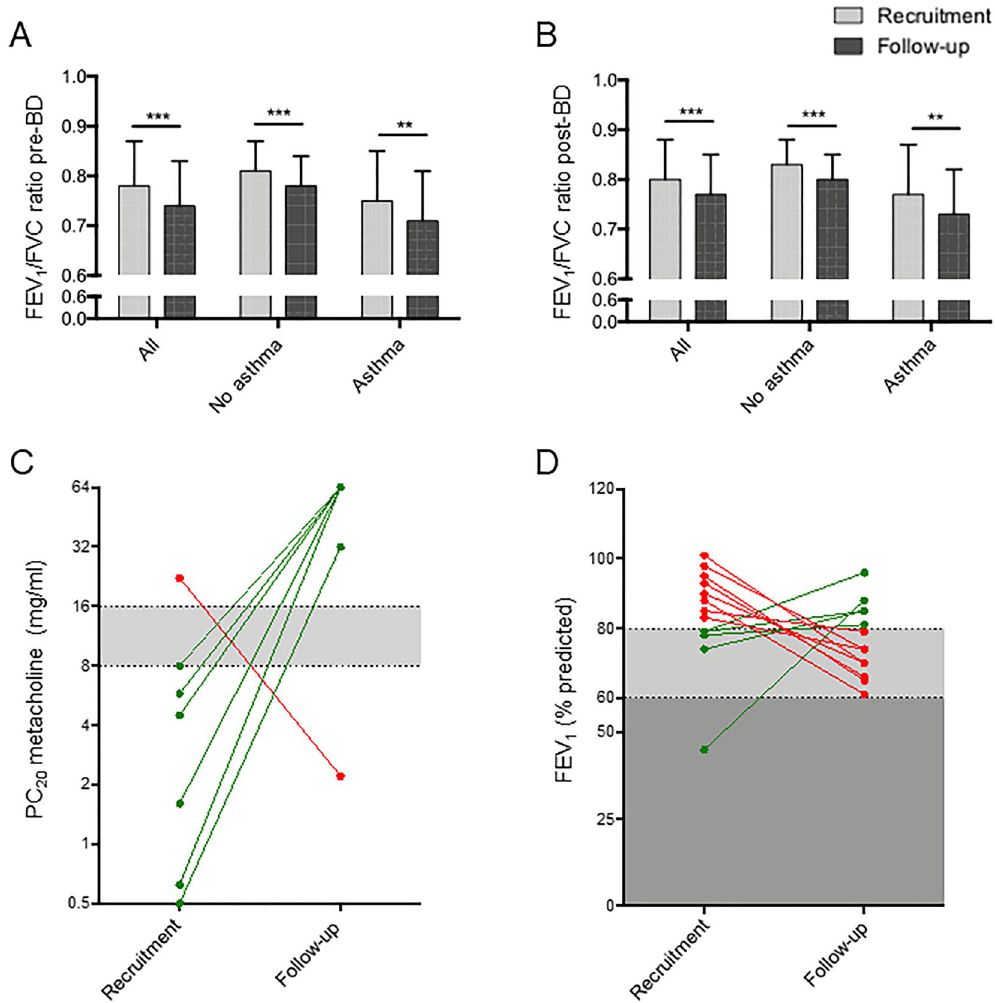
Figure 3. Variations in lung function. Changes in the forced expiratory volume in 1 s on the forced vital capacity (FEV 1 /FVC) ratio were observed between recruitment and follow-up considering values ( A ) before or ( B ) after the use of bronchodilators (BDs). The All group includes all participants in the subsample, the No asthma group comprises individuals without asthma at recruitment, and the Asthma group include participants with confirmed asthma diagnosis at recruitment. p values < 0.001 are indicated by two asterisks and p values < 0.0001 are indicated by three asterisks. ( C ) Representation of participants with asthma at recruitment who exhibited either an increase (from PC 20 ≤ 8 mg/ml to ≥ 16 mg/ml; n = 7) or a decrease (from PC 20 ≥ 16 mg/ ml to ≤ 8 mg/ml; n = 1) in PC 20 measurements. ( D ) Representations of participants with asthma at recruitment who showed an increase (from FEV 1 < 80% to > 80%; n = 5) or a decrease (from FEV 1 > 80% to < 80%; n = 8) in measurements of FEV 1 of predicted